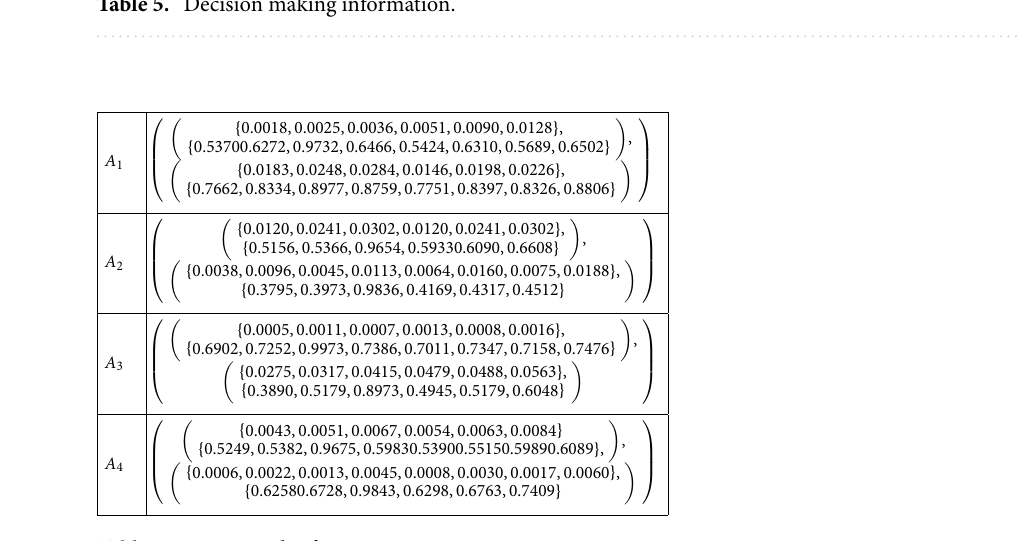
Table 6. Aggregated information using q -ROHFREWG.